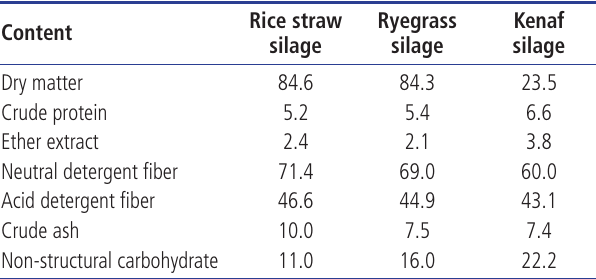
Table 1. Chemical composition of experimental diet (% dry matter basis)